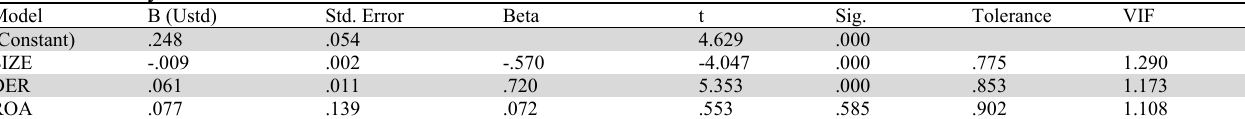
Multicollinearity test Model